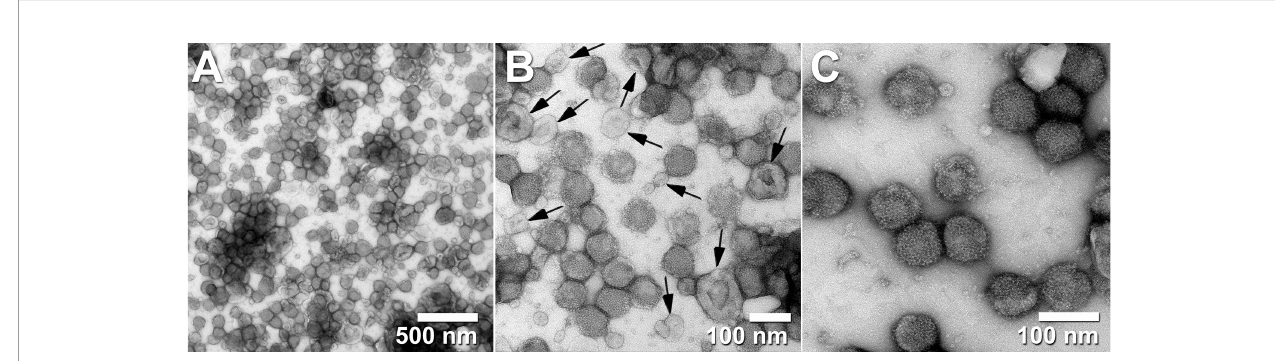
FIGURE 2 | Transmission electron micrographs of in fl uenza virus A/Puerto Rico/8/34 H1N1 puri fi ed with steric exclusion chromatography (SXC) and pseudo-af fi nity chromatography with a sulfated cellulose membrane adsorber. Co-eluted exosome-like vesicles are visible in panels (A, B) and labeled with black arrows in panel (B) . Panel (C) displays homogeneous (mostly intact) viral particles. Black arrows were added to the original published fi gure to highlight examples of extracellular vesicles (with lighter electron-density and collapsed cup shape) side by side with intact viral particles (non-collapsed round particles with higher electron density). All images are from the same sample at different magni fi cations. Pictures taken by Dietmar Riedel from the Max-Planck-Institute for Biophysical Chemistry in Göttingen, Germany. Reproduced with permission from Dr.-Ing. Pavel A Marichal-Gallardo, Max-Planck-Institute for Biophysical Chemistry in Göttingen, Germany (license CC BY-NC-SA